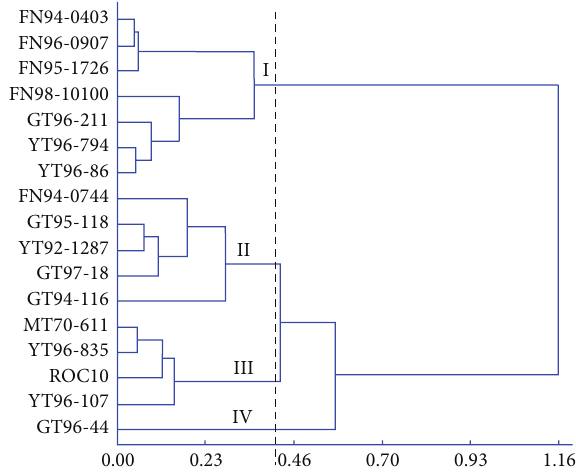
Figure 1: A clustering dendrogram based on photosynthetic param- eters of 17 sugarcane varieties.